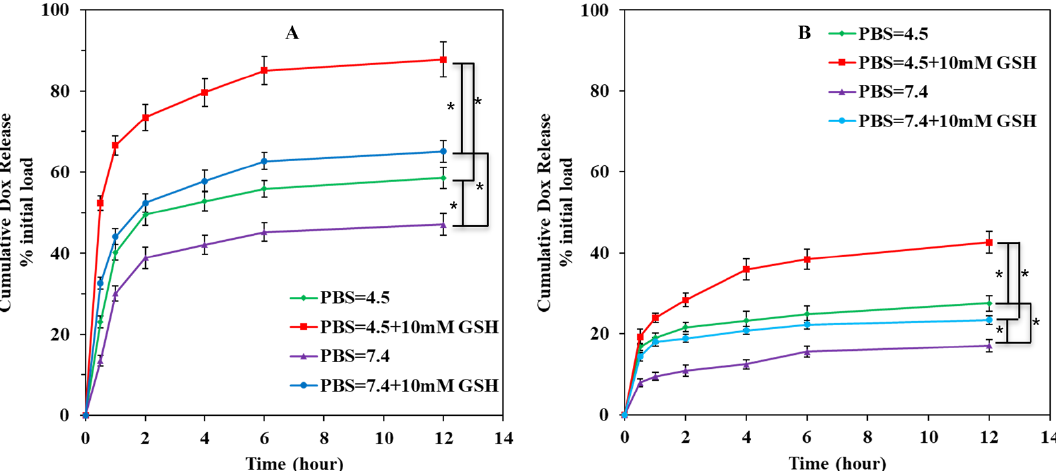
Figure 7 . Redox/pH dual-responsive DOX release profiles from DOX-loaded HA–SH/CS Figure 7. Redox/pH dual-responsive DOX release profiles from DOX-loaded HA-SH/CS nanoparticles under different nanoparticles under different conditions of pH and GSH concentrations. (A) Negative na- conditions of pH and GSH concentrations. ( A ) Negative nanoparticle (R = 0.10). ( B ) Positive nanoparticles (R = 0.50). There noparticle (R = 0.10). (B) Positive nanoparticles (R = 0.50). There was a significant differ- was a significant difference between different conditions for both nanoparticles (* p < ence between different conditions for both nanoparticles (* p < 0.05).